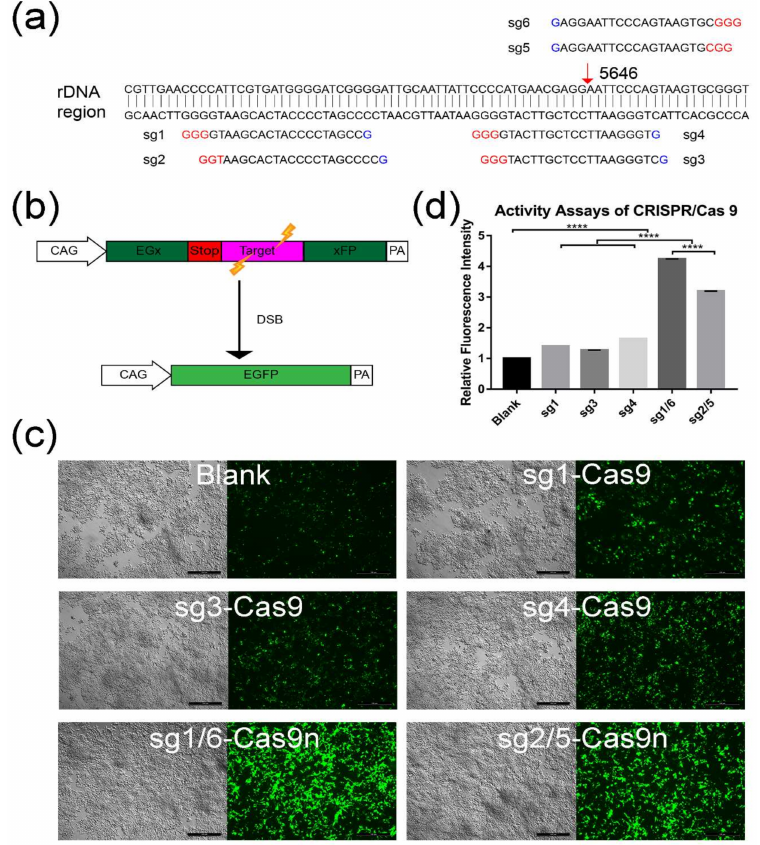
Figure 1. Activity assay for different sgRNA-CRISPR/Cas9 groups. ( a ) Binding position of six different sgRNAs. Red arrow indicates the targeting site in the rDNA region. ( b ) Schematic illustration of activity assays by using the pCAG-EGx-Target-xFP system. The EGFP (enhanced green fluorescence protein) cDNA was divided to two parts, EGx and xFP, in which the “x” represents a repeat fragment of 482 bp. The two parts were separated by the target region ( a ) 77 bp fragment cloned from the rDNA region) along with the stop code. When the sgRNA-CRISPR/Cas9 worked and introduced double strand breaks (DSB), the EGFP cassette was reconstituted by either HDR or SSA. Thus, the green fluorescence could be observed. ( c ) The activity assay for sgRNA-CRISPR/Cas9 was conducted by co-transfecting HEK 293T cells with pCAG-EGx-Target-xFP and sgRNA-CRISPR/Cas9 or sgRNA-CRISPR/Cas9n plasmids (named sg1-Cas9n, sg2-Cas9n, sg5-Cas9n, sg6-Cas9n sg1-Cas9, sg3-Cas9, and sg4-Cas9). sg1/6-Cas9n group means co-transfection with sg1-Cas9n and sg6-Cas9n. In the same way, sg2/5-Cas9n group means co-transfection with sg1-Cas9n and sg6-Cas9n. Blank represented cells only transfected with the plasmid pCAG-EGx-Target-xFP. After 72 h, the green fluorescence of transfected cells was visualized. Scale bar: 500 µ m. ( d ) GFP fluorescence intensity of each group was quantified and analyzed with Image J. GraphPad Prism 7.0 was used for calculation and statistics analysis. The relative fluorescence intensity was normalized to blank. (****, p <